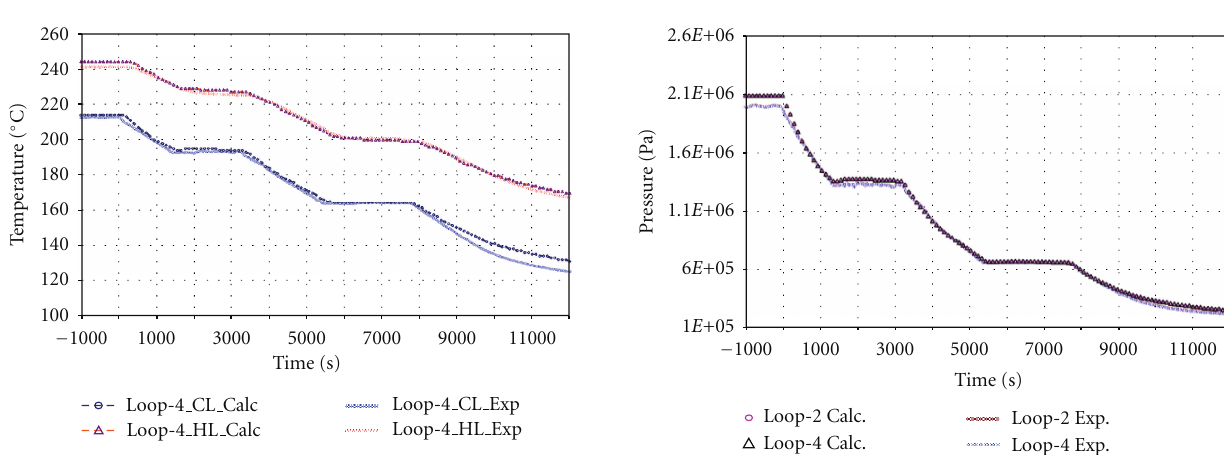
Figure 17: Run-3: Secondary side pressure evolution in the active